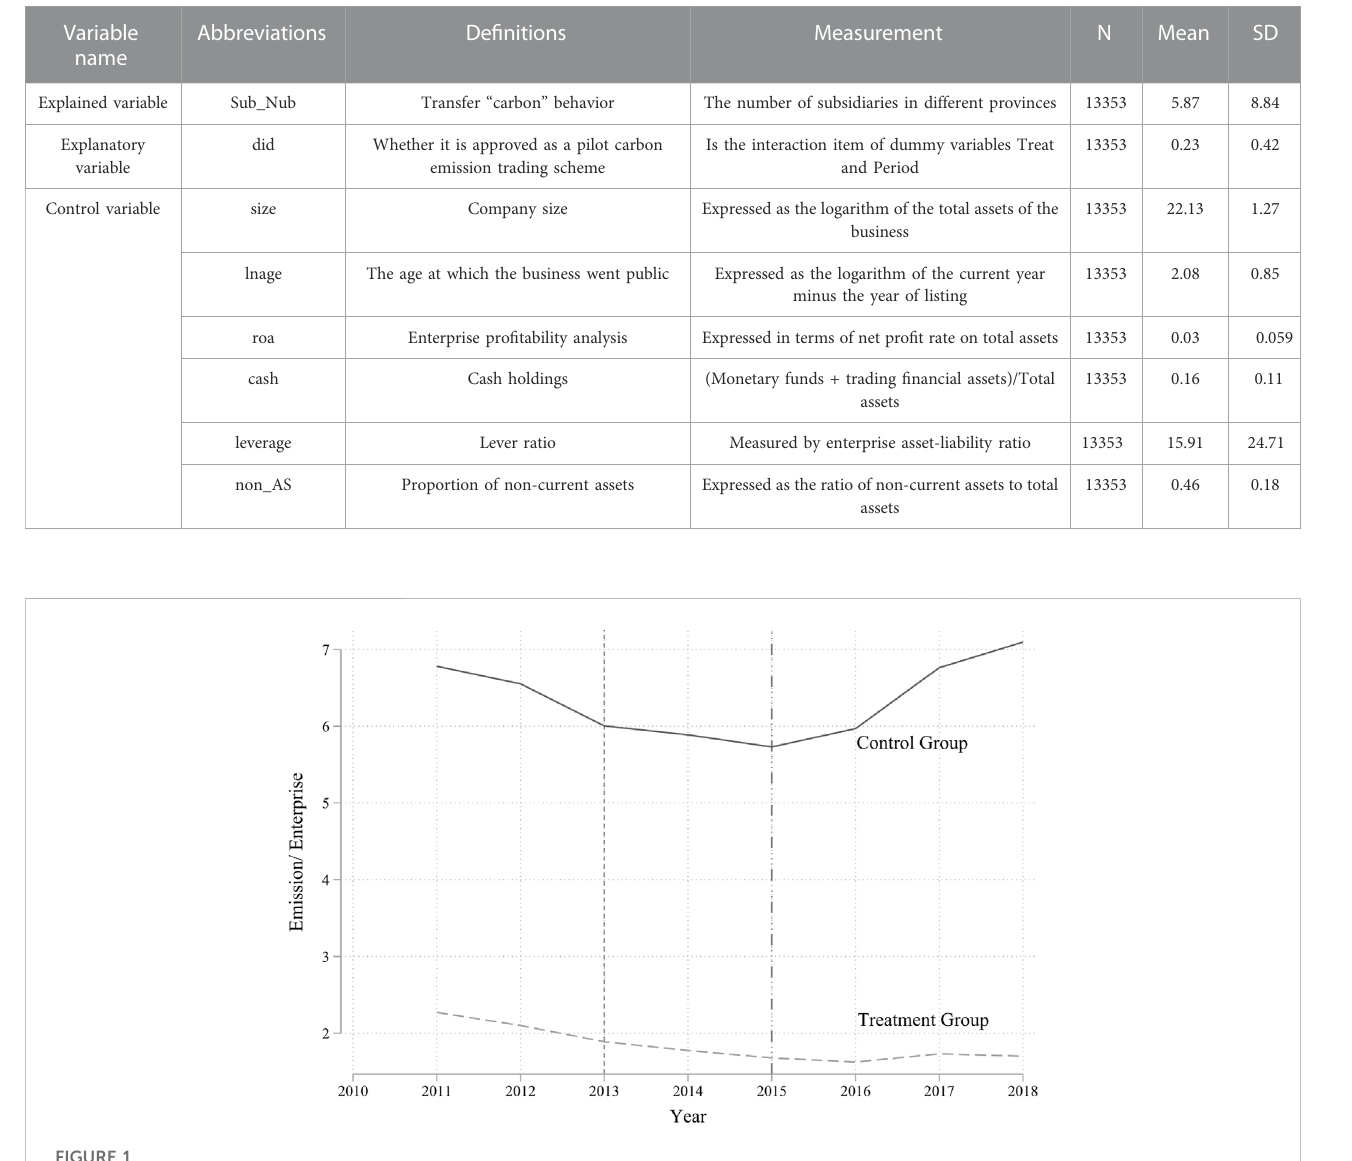
FIGURE 1 Facts about the characteristics of “ carbon ” migration of